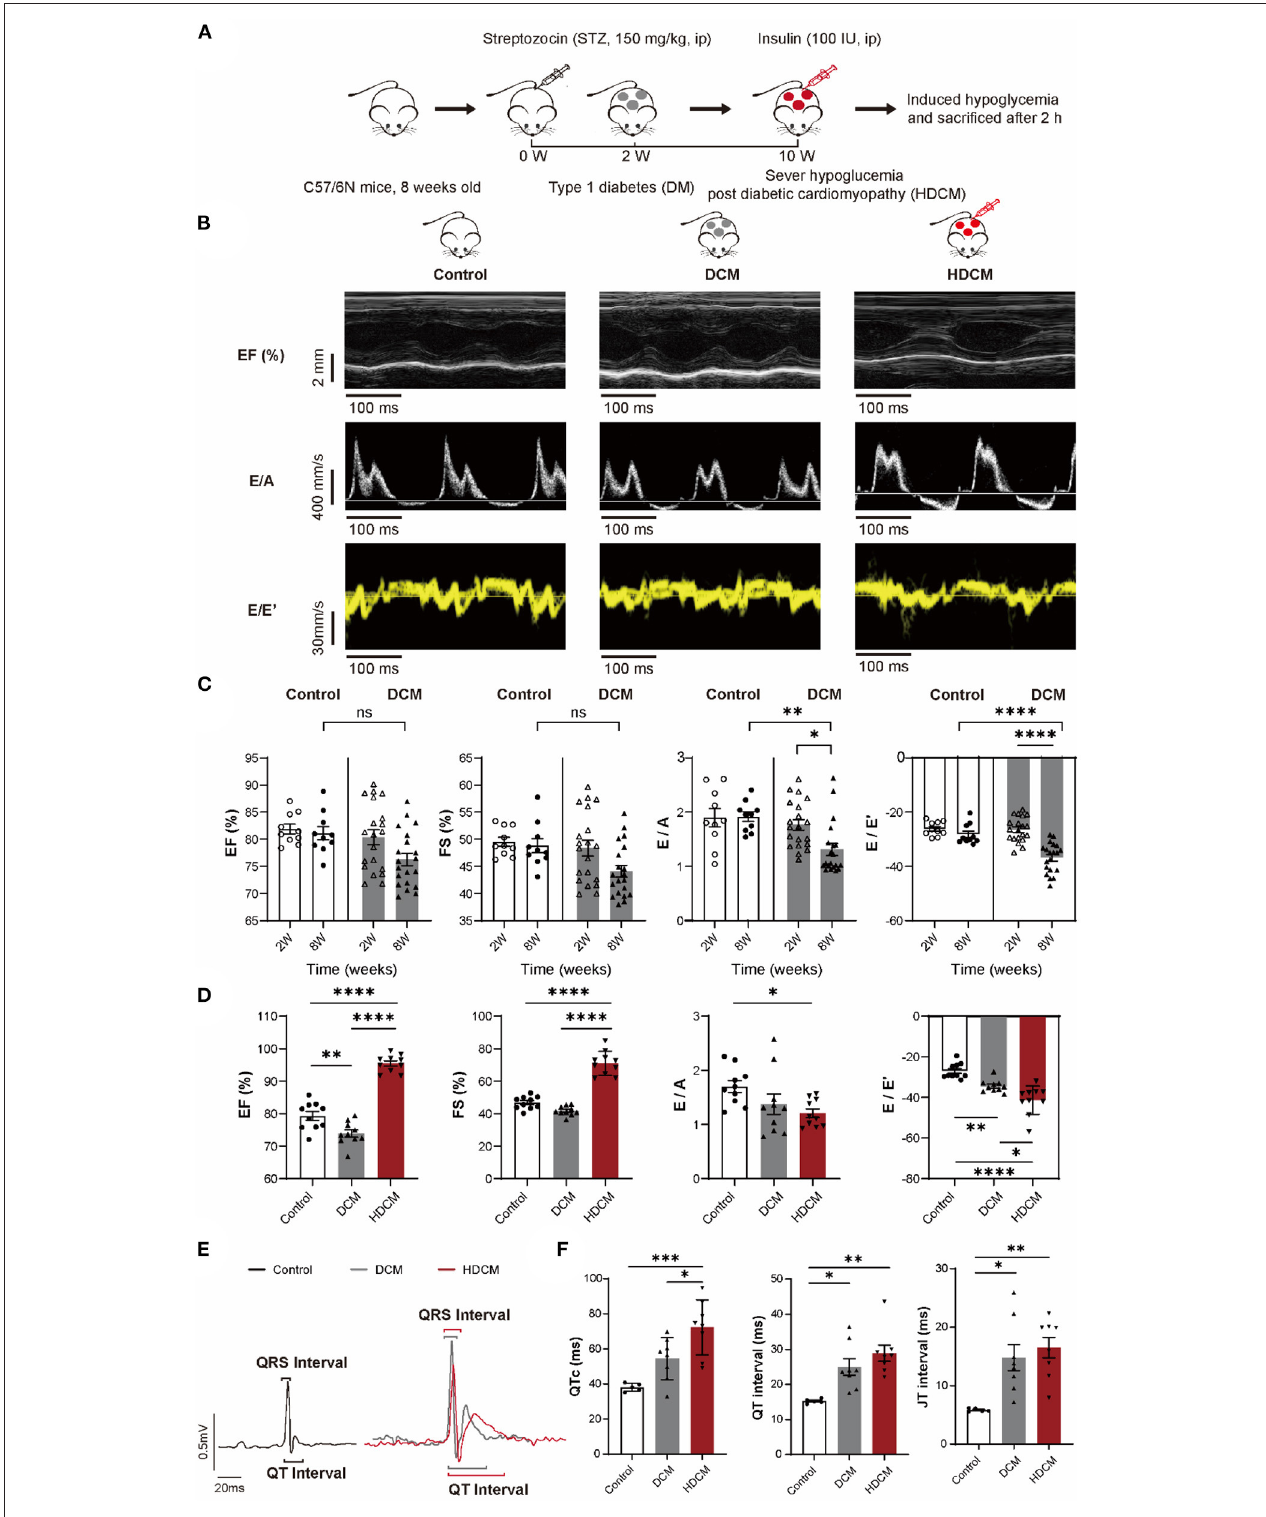
FIGURE 2 | HDCM mice display worse diastolic dysfunction and increased cardiac arrhythmia susceptibility than control and diabetic cardiomyopathy (DCM) mice. (A) Schematic diagram of mice modeling. Mice were divided into the control group and the DM group. DM mice were injected with streptozotocin (STZ) (150